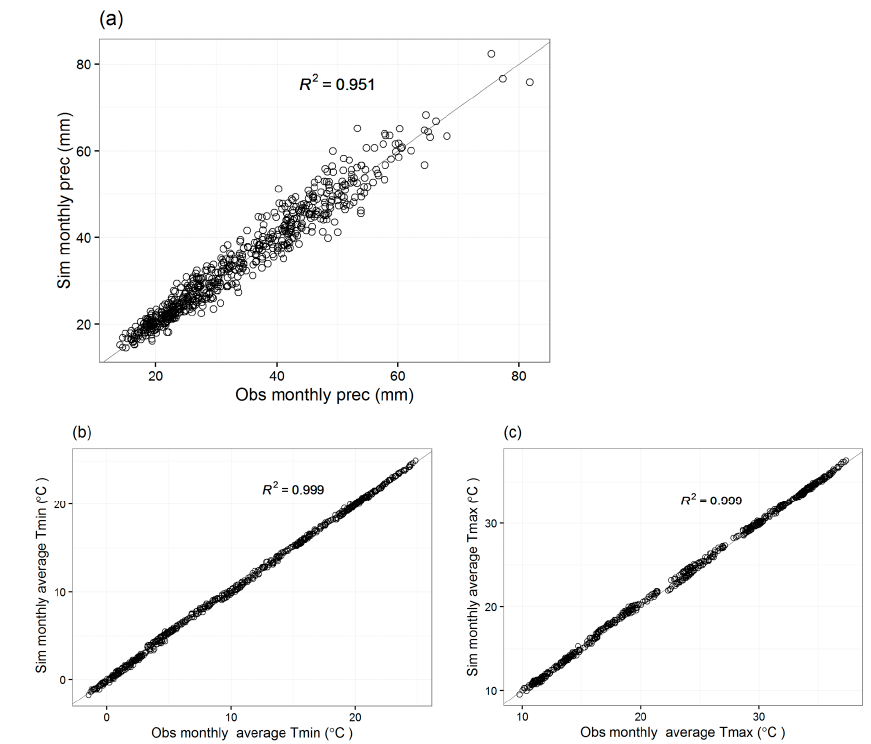
Figure 2. Observed and simulated (LARS ‐ WG) monthly precipitation ( a ); and monthly average minimum ( b ); and maximum temperatures ( c ). Results are based on separate calibrations for 55 grids in the basin.